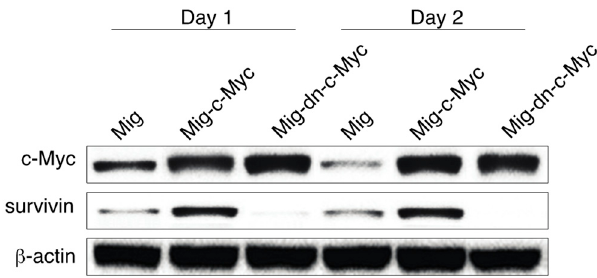
Figure 5. c-Myc controls survivin expression in Notch-activated cells. The bone marrow–derived CD117 + HSCs from OT-I TCR transgenic mice were co-cultured on SNL feeders and transduced with retroviral vectors (Mig Mig–c-Myc, or Mig–dn c-Myc). GFP + HSCs cells were sorted and co-cultured with OP9-DLL1/DLL4 cells and cytokines (IL-7 and Flt3L) for two days. GFP + HSCs were sorted and analyzed for survivin and β -actin by immunoblot. Data shown are representative of three identical experiments.